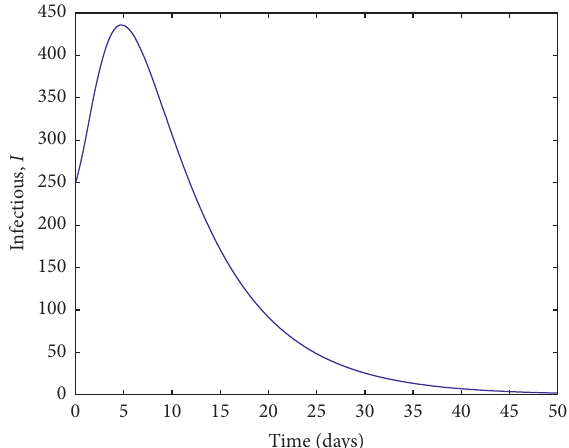
Figure 15: Evolution of the infectious in the absence of external actions.